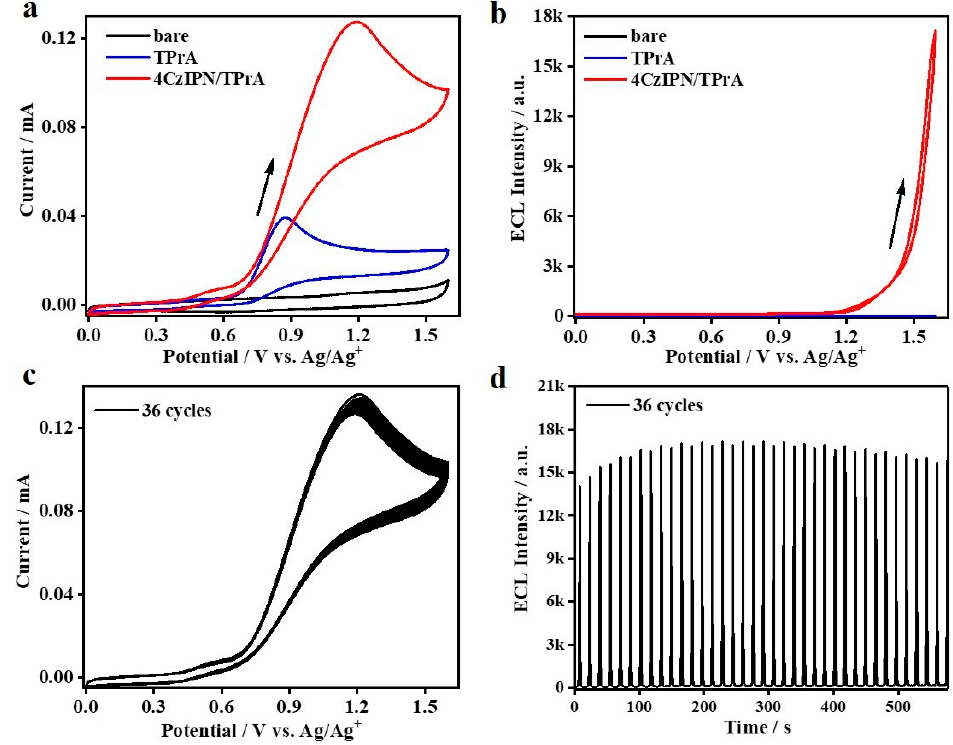
Figure 3. CVs ( a ) and ECL curves ( b ) of bare DCM containing 0.1M TBAPF 6 , bare DCM containing 0.1 M TBAPF 6 and 40 mM TPrA, or 0.1 mM 4CzIPN in DCM containing 0.1 M TBAPF 6 and 40 mM TPrA. Stability of CV curves ( c ) and ECL intensity ( d ) after continued scans of 4CzIPN in the presence of 40 mM TPrA.